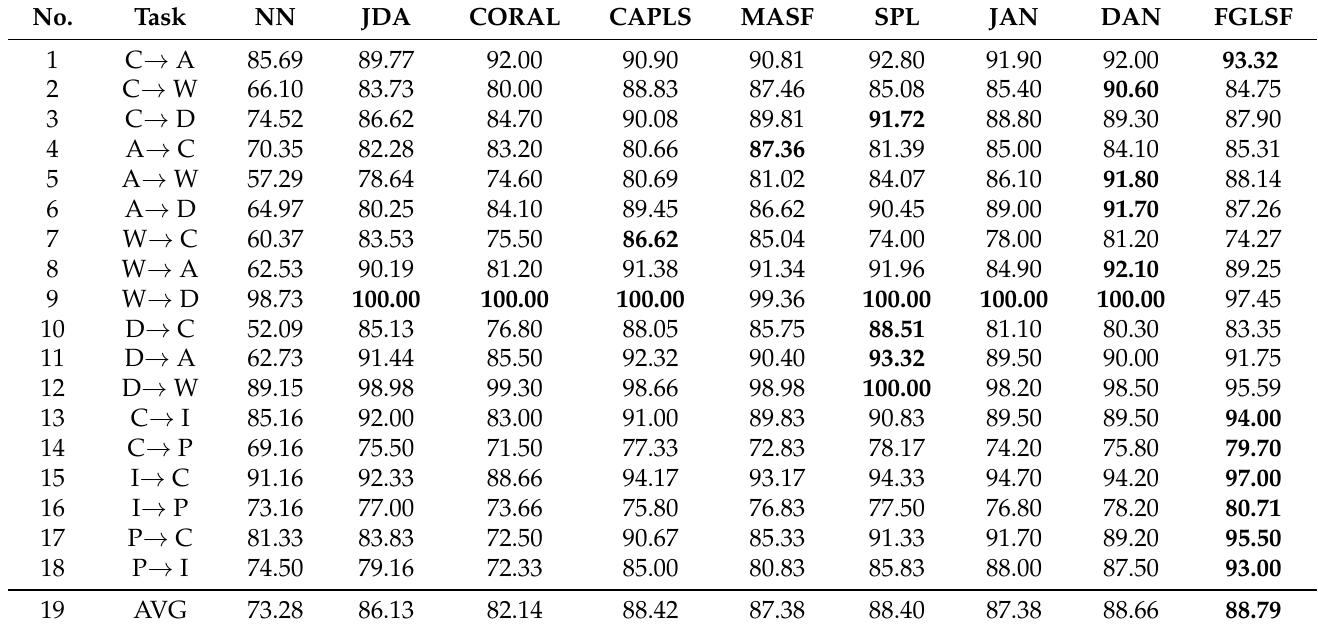
Table 2. Performance (accuracy %) on Office-Caltech10 (No. 1–12) and ImageCLEF (No.